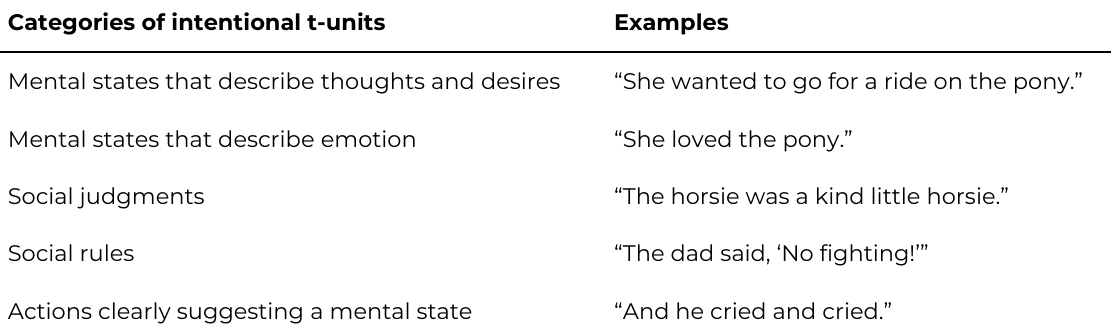
Table 3: Categories of intentional t-units with examples Categories of intentional